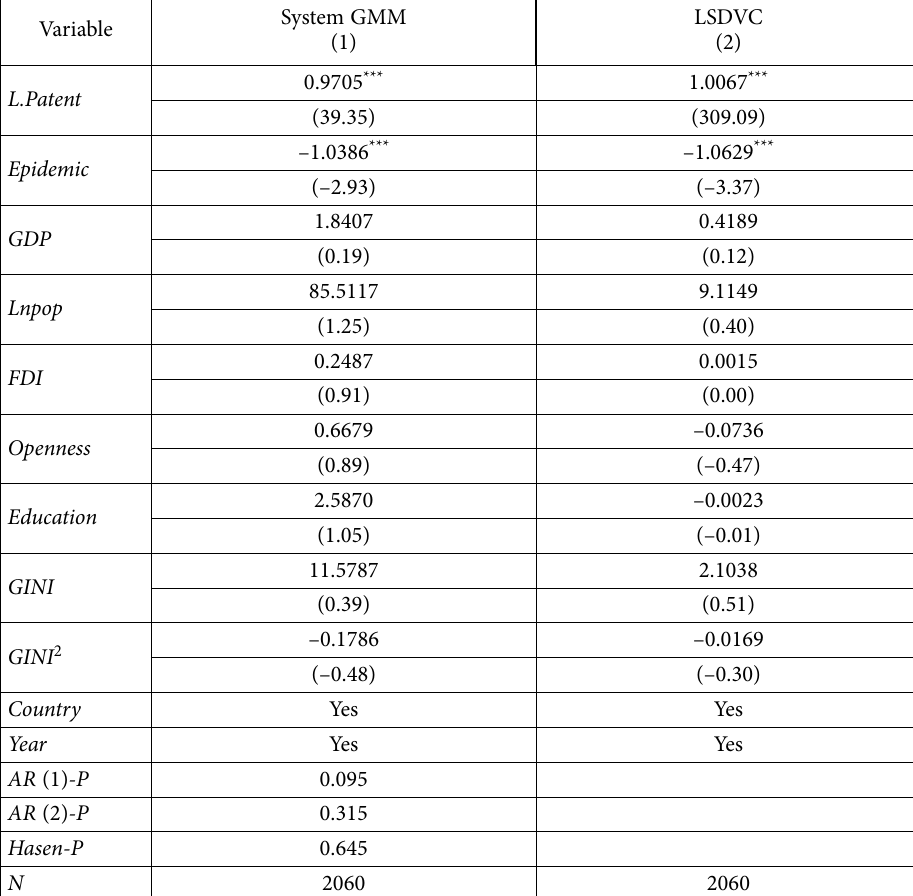
Table 8. Robustness tests: system GMM and LSDVC